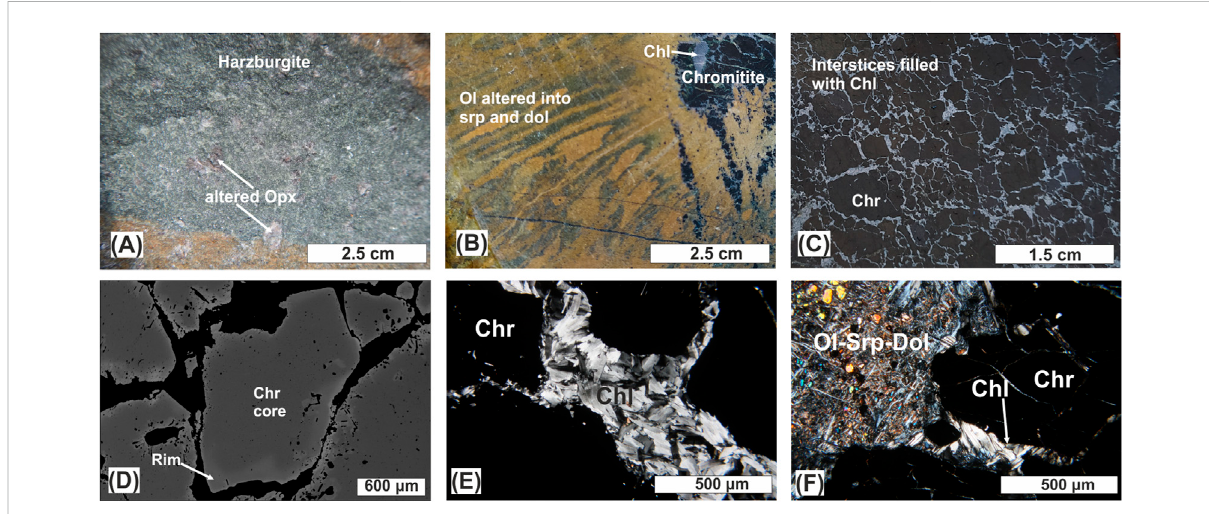
FIGURE 3 (A) Altered harzburgite of the NR mantle section. (B) Dunite envelope of NR chromitite, altered into dolomite and serpentine. (C) Cataclastic massive NR chromitite with interstices fi lled with chlorite. (D) B.S.I. of NR chromitite, note the evidently low degree of alteration of the chromite. (E)